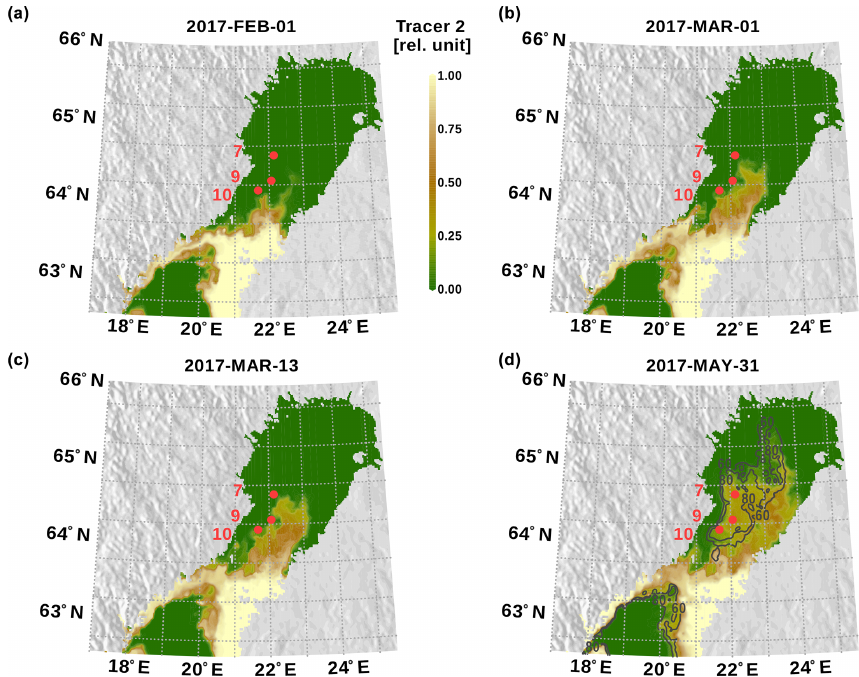
Figure 10. Bothnian Sea surface tracer concentration in the bottom model layer. Red dots indicate the observation stations. In panel (d) , bathymetry contour lines for 60 and 80m depths are shown.